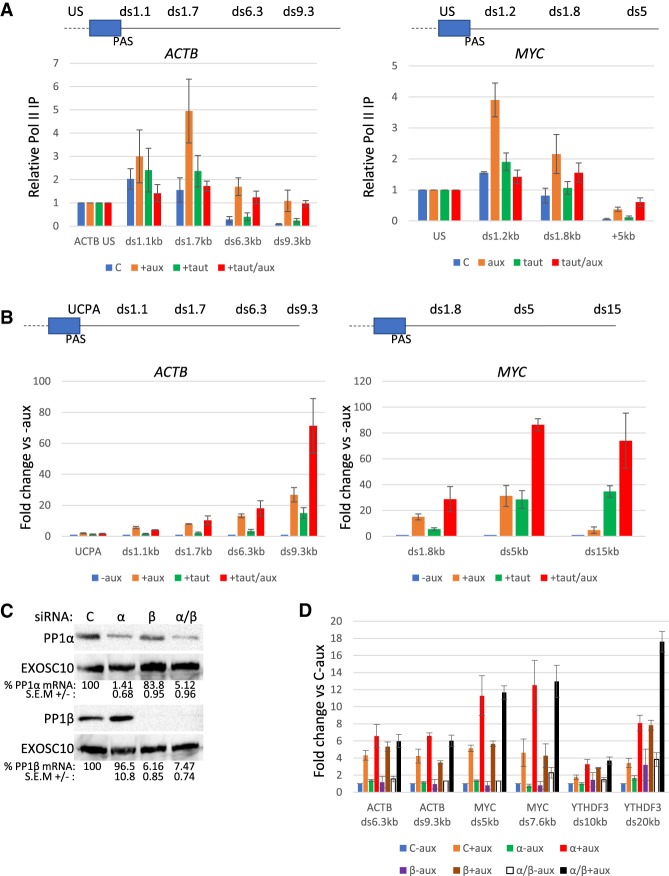
PP1 activity underpins the piling up of Pol II in the absence of XRN2. (A) Pol II ChIP on ACTB and MYC performed in XRN2-AID cells that were either untreated or treated with auxin, tautomycetin or both (auxin 2 h, tautomycetin 18 h). Graph shows Pol II IP relative to ACTB US/MYC US for each sample. n = 3. Error bars are SEM. (B) qRT-PCR analysis of ACTB and MYC readthrough transcription in XRN2-AID cells that were either untreated or treated with auxin, tautomycetin, or both (auxin 2 h, tautomycetin 18 h). Graph shows RNA fold change at each amplicon relative to untreated (-aux) cells following normalization to spliced ACTB. n = 3. Error bars are SEM. (C) Western blotting of XRN2-AID cells treated with control, PP1α, PP1β, or PP1α and β siRNAs. EXOSC10 is shown as a loading control. mRNA levels (n = 3) are shown under each blot relative to those in control siRNA treated cells (shown as 100%) after normalization to spliced ACTB transcripts. (D) qRT-PCR analysis of ACTB, MYC, and YTHDF3 readthrough transcription in XRN2-AID cells that were treated with control, PP1α, PP1β, or PP1α and β siRNAs and then with auxin (2 h) or not. Graph shows RNA fold change at each amplicon relative to control siRNA transfected cells not treated with auxin following normalization to spliced ACTB. n = 3. Error bars are SEM.